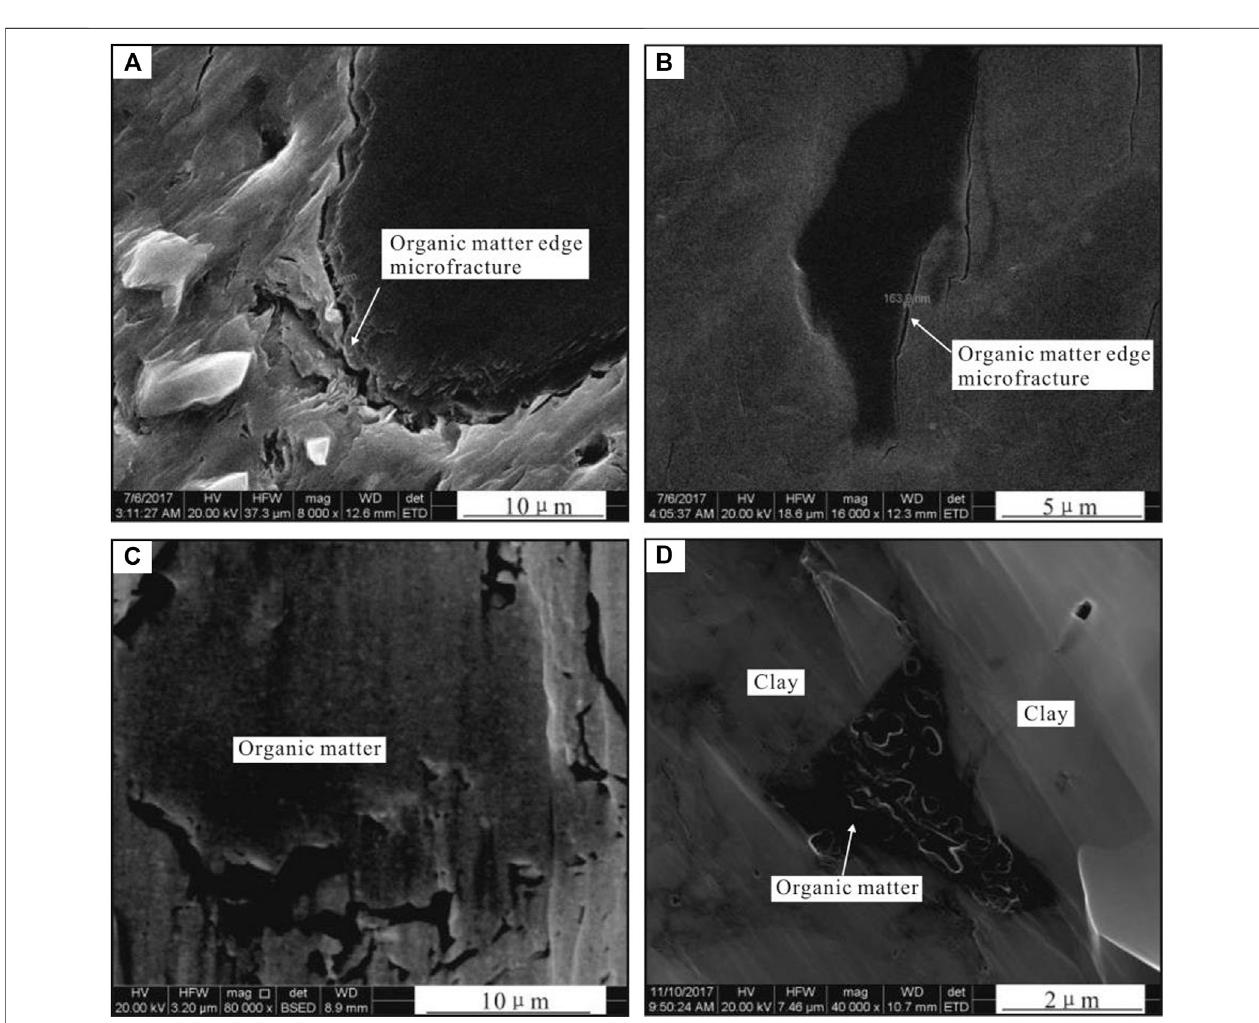
FIGURE7| Changesinthemorphologyoforganicmatterporesunderdifferentthermalevolutiondegrees.Notes: (A) WellY120,3,507.2 m, R o (cid:2) 0.59%,argonion polishing image; (B) Well Y117, 3,401.93 m, R o (cid:2) 0.56%, argon ion polishing image; (C) Well BS5, 4,764.45 m, R o (cid:2) 1.73%, argon ion polishing image; (D) Well Lc-1, 2,477 m, R o (cid:2) 3.02%, argon ion polishing image.